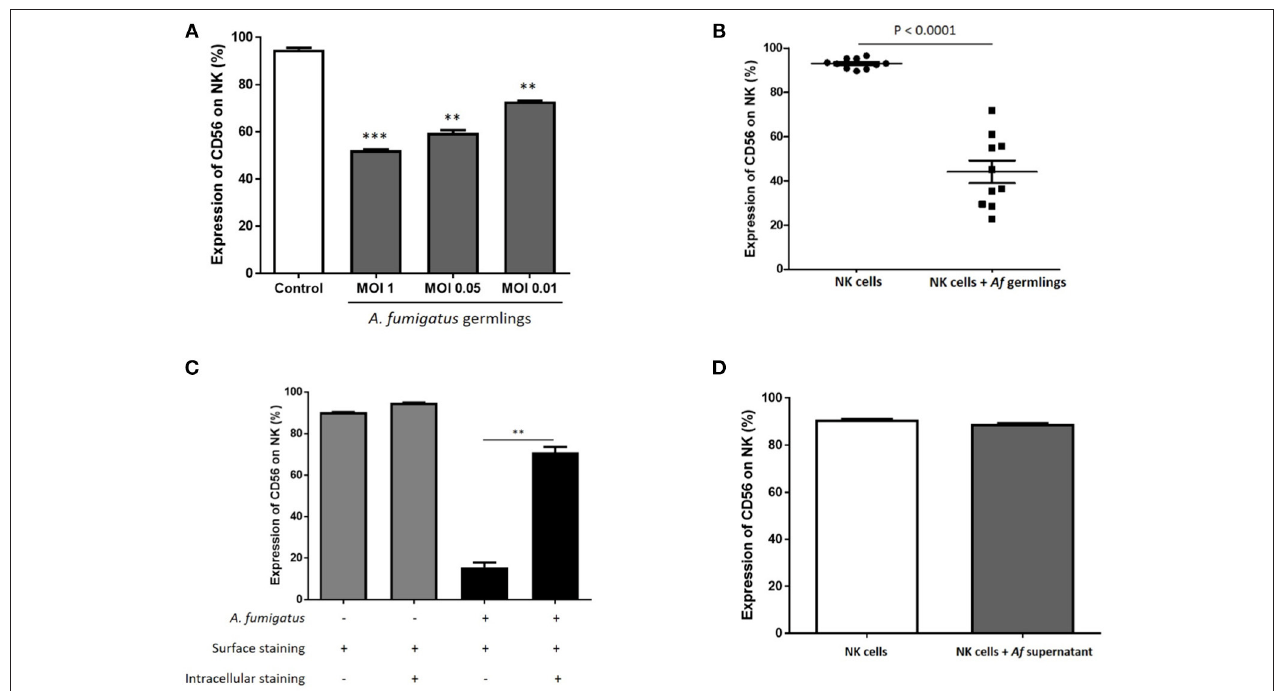
FIGURE 4 | NK cell challenge with live A. fumigatus results in a contact-dependent reduction in CD56 surface expression as a result of CD56 internalisation (A) . CD56 NK cell surface expression is reduced in the presence of A. fumigatus . Human NK cells were incubated overnight with A. fumigatus germlings at MOI = 1, MOI = 0.05, and MOI = 0.01. CD56 expression was determined by FACS, gating live NK cells. Bar graph shows the mean + SEM of CD56 expression on NK cells. Statistical analysis was performed using the Student’s unpaired t -test. ** p < 0.01, *** p < 0.001. This data is representative of three independent experiments. (B) A. fumigatus co-incubation consistently reduces NK cells surface CD56 expression. Human NK cells from 10 different healthy donors were incubated overnight with A. fumigatus germlings at MOI = 0.05. CD56 expression was determined by FACS, gating live NK cells. Statistical analysis was performed using the Student’s paired t -test. n = 10 *** p < 0.001 (C) . A. fumigatus induces CD56 internalisation on NK cells. Human NK cells were incubated overnight with A. fumigatus germlings at MOI = 0.05. NK cells were stained extracellularly or extracellularly and intracellularly with CD56 antibody. CD56 expression was determined by FACS, gating live NK cells. Bar graph shows the mean + SEM of CD56 expression on NK cells. This data is representative of three independent experiments. Statistical analysis was performed using the Student’s unpaired t -test. ** p < 0.01 (D) . CD56 downregulation on NK cell surface is dependent on direct contact with A. fumigatus . Human NK cells were incubated overnight with A. fumigatus culture supernatant. CD56 expression was determined by FACS, gating live NK cells. Bar graph shows the mean + SEM of CD56 expression on NK cells. This data is representative of three independent experiments. Statistical analysis was performed using the Student’s unpaired t